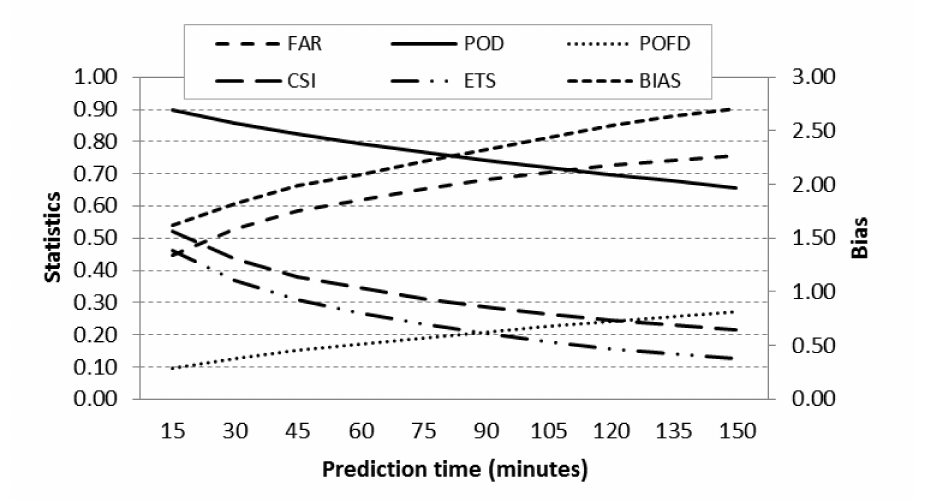
Figure 6. Verification statistics per prediction time (minutes) up to 150 min lead time, calculated over the subset